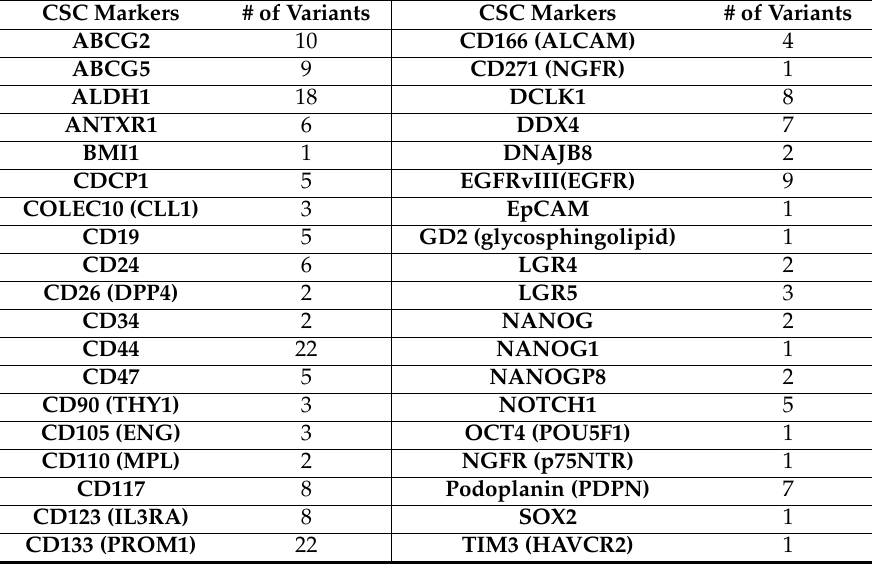
Figure 1. CD44 and CD44 splice variants. ( a ) CD44 is a transmembrane glycoprotein. CD44 consists of the extracellular domain, the transmembrane domain, and the cytoplasmic domain. The ligand binding / extracellular domain interacts with hyaluronic acid, osteopontin, chondroitin, collagen, and fibronectin. The CD44 cytoplasmic domain mediates transcription. ( b ) The CD44 gene consists of 20 exons. CD44 gene, exons 1–5 and 16–20 produce the standard isoform of CD44, referred to as the CD44 standard (CD44s). The remaining exons 6–15 are alternatively spliced and assembled with the ten exons contained in the CD44 standard isoform and are referred to as the CD44 variant isoforms (CD44v). Table 2. Major cancer stem cell markers and their variants.